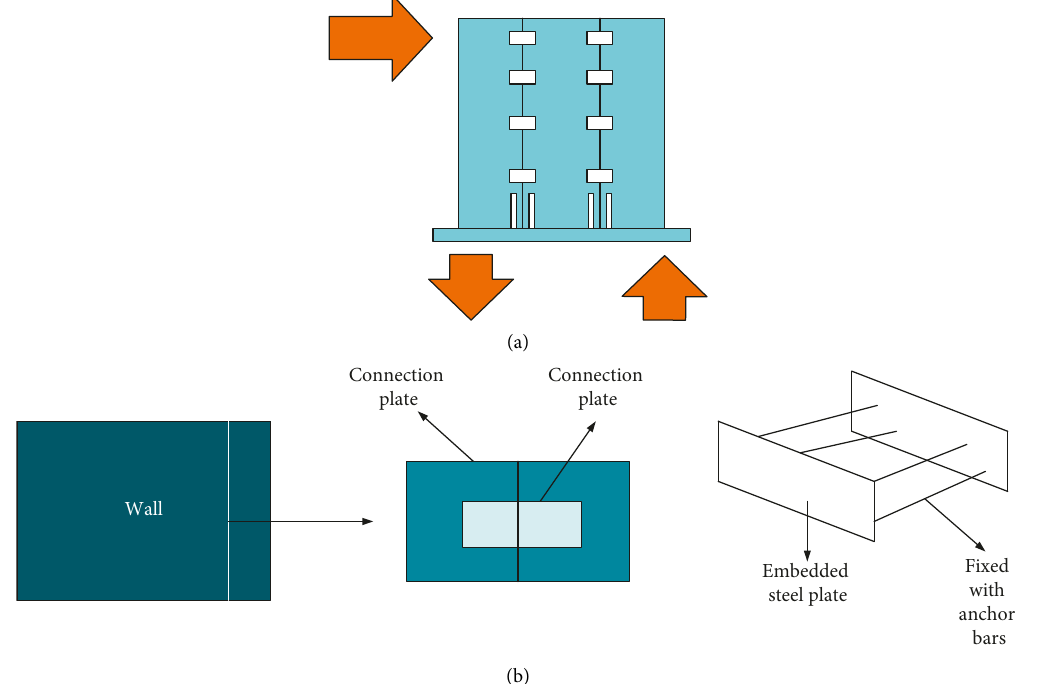
Figure 2: Vertical joint shear wall structure: (a) embedded position in steel plate bolt wall and (b) structure in fabricated shear wall.